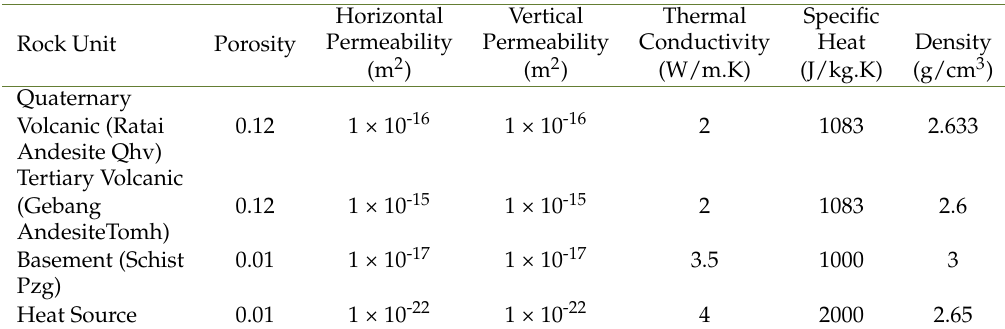
Table 1. Characteristic’s rock data as input parameters for numerically predicting heat fluid transfer in Way Ratai geothermal field.